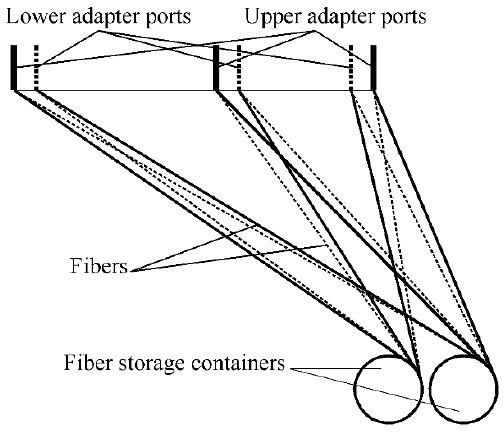
Figure 22. Double fiber storage containers: column connect diagram.